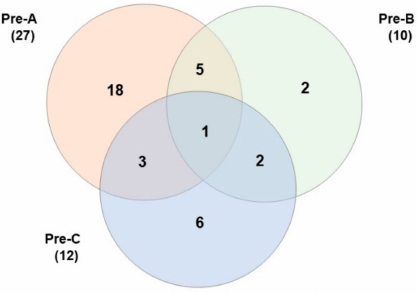
Figure 5. Venn diagram of the number of colonies at transect A, B, and C before baiting in 2020 at RFS.